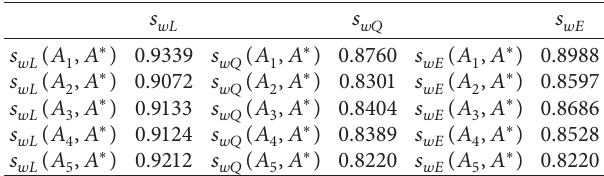
Table 6: Similarity measures from each alternative A alternative. s wL